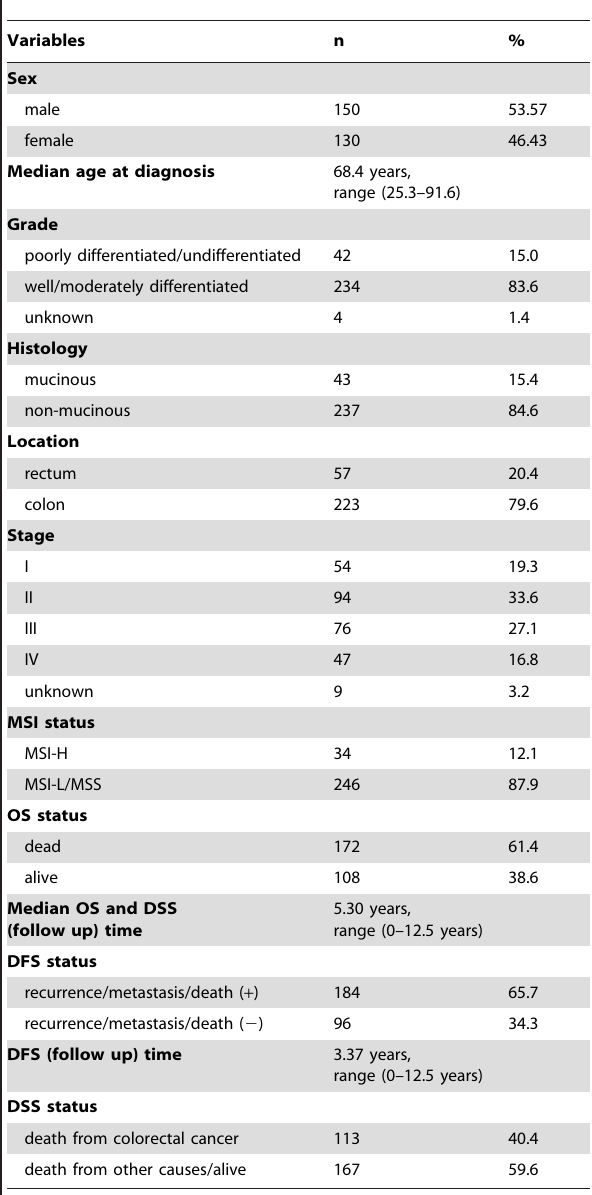
Table 2. Baseline characteristics of the patient cohort.